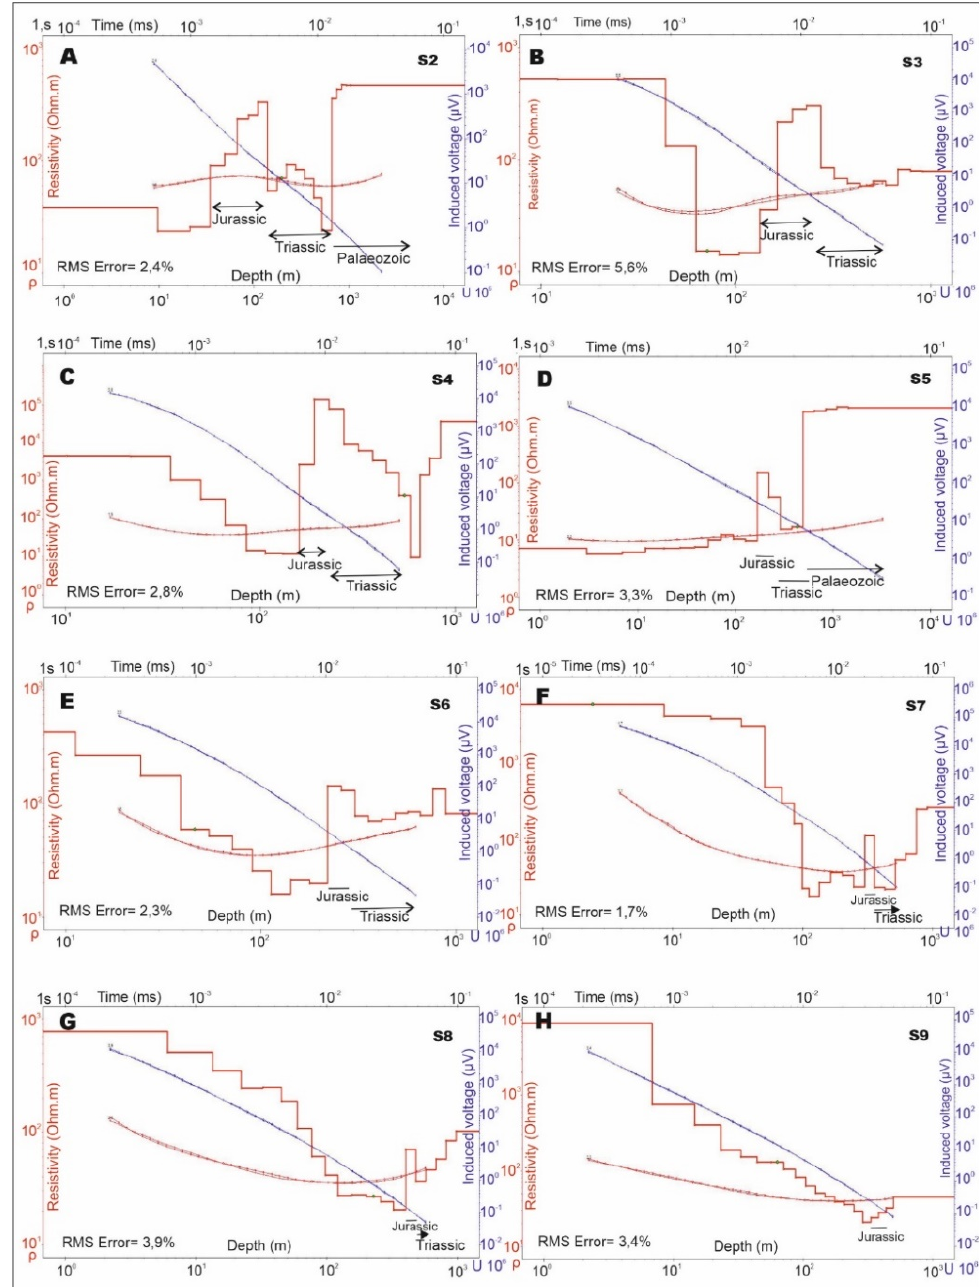
Figure 6. Representation of the induced voltage curves (blue line) and apparent resistivity (red line) as a function of time at stations S2 ( A ), S3 ( B ), S4 ( C ), S5 ( D ), S6 ( E ), S7 ( F ), S8 ( G ), and S9 ( H ) using a central-loop device. For each of them, the fit between the field line and the line of the ZONDTEM1D software model has been represented. The straight red lines represent the resistivity as a function of the depth, interpreted after data inversion. A good fit is deduced, with RMS error value ranges between 1.7% and